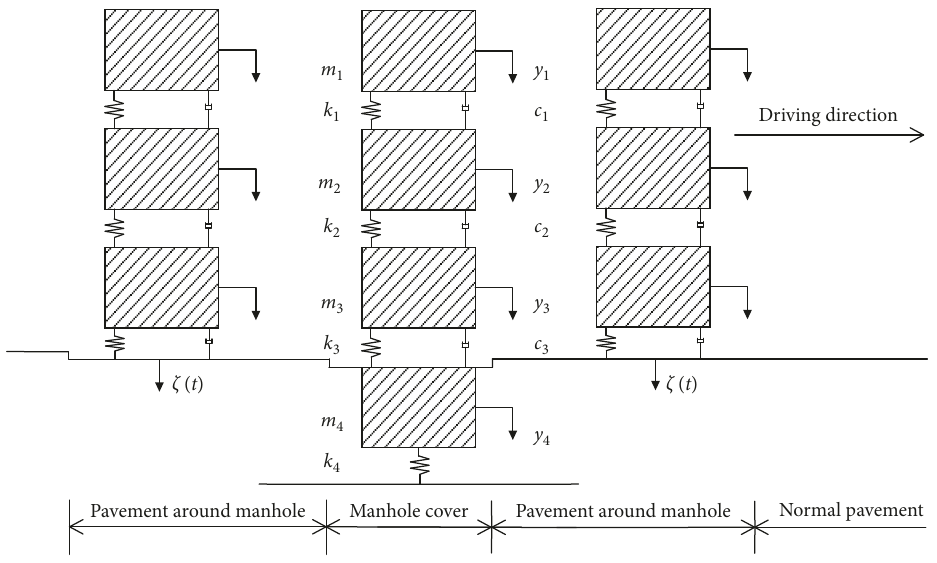
Figure 1: Human-vehicle-manhole cover vibration model. Table 1: Parameters for the vehicle and manhole